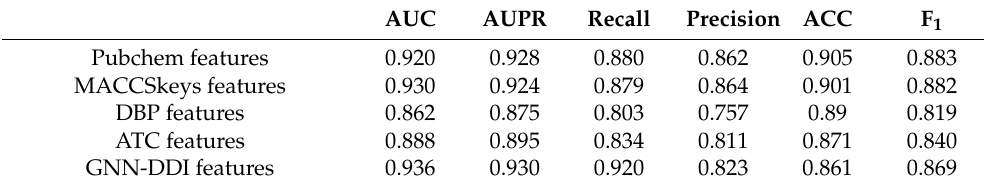
Table 2. Comparison results of the structure features learned by GNN-DDI and other chemical and biological